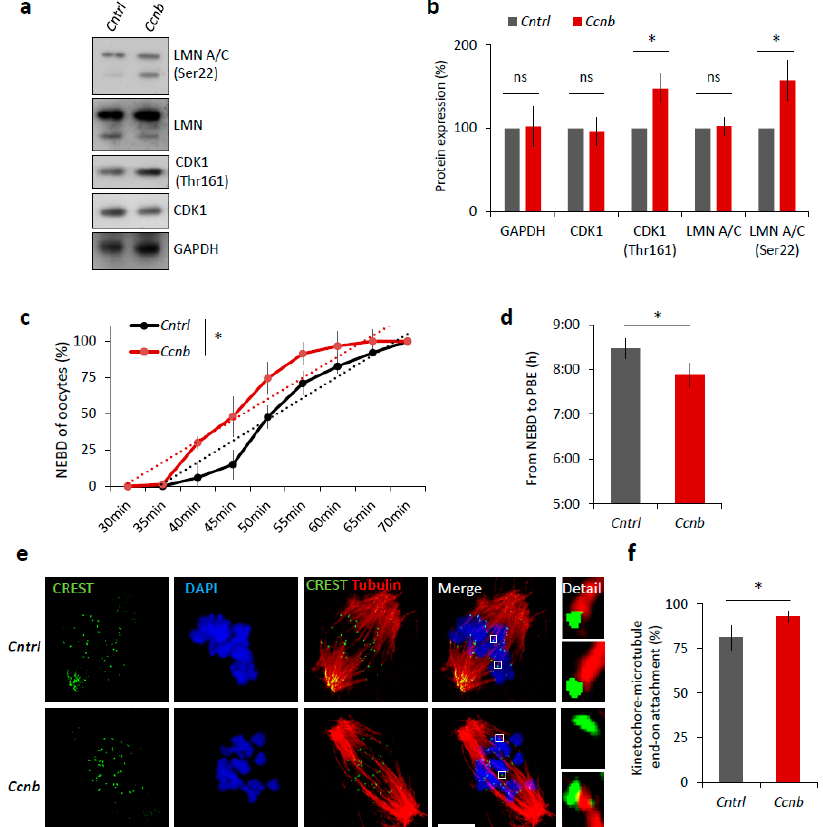
Figure 6. Elevated MPF activity is responsible for meiosis I acceleration in oocytes. ( a ) Western blot analysis of LMN A/C (Ser22), LMN A/C, CDK1 (Thr161), CDK1, and GAPDH in the post-NEBD oocytes (3 h) injected with Ccnb RNA or control Gfp RNA ( Cntrl) . See Figure S4 for the over-expression of CCNB in oocytes. Representative images from at least three experiments of biologically different samples. ( b ) Quantification of protein expression, LMN A/C, and CDK1 phosphorylation. From three experiments of biologically different samples. Values obtained for the YF group were set as 100%. Data represent mean ± SD; ns non-significant; * p < 0.05; Student’s t- test. ( c ) Timing of NEBD of YF oocytes microinjected with Gfp ( n = 46; black line) and Ccnb cRNA ( n = 51; red line). From three experimental data sets of biologically different samples. Trend line is depicted by dot lines. Data represent mean ± SD. * p < 0.05, Student’s t- test. ( d ) Time from NEBD to PBE in oocytes from YF injected with RNA coding for Gfp ( n = 46; t = 8:25 h) and Ccnb ( n = 51; t = 7:52 h). Data represent mean ± SD and data are from at least three experiments of biologically different samples. *** p < 0.001, Student’s t -test. ( e ) Representative Z-projections from the assessment of cold stable attachments of kinetochores (KT, CREST, green) to microtubule (MT, tubulin, red) of oocytes microinjected with control Gfp and Ccnb cRNA. Representative images are from three experiments of biologically different samples (scale bar, 10 µ m). ( f ) The percentage of cold stable end-on MT to KT attachments in each group averaged over multiple cells ( n ≥ 28) 6 h post-IBMX-wash. Kinetochore-MT end-on attachments were quantified. The morphology of kinetochores analyzed is specified in detail. Data represent mean ± SD. * p < 0.05, Student’s t